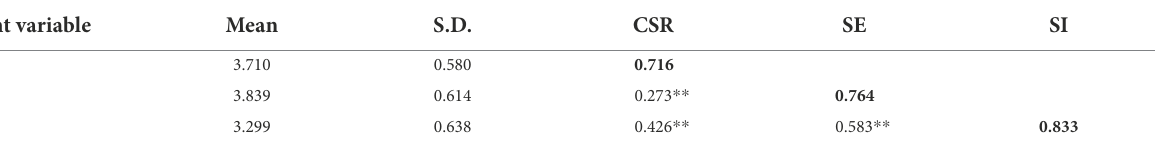
TABLE 5 Correlation coefficient analysis.